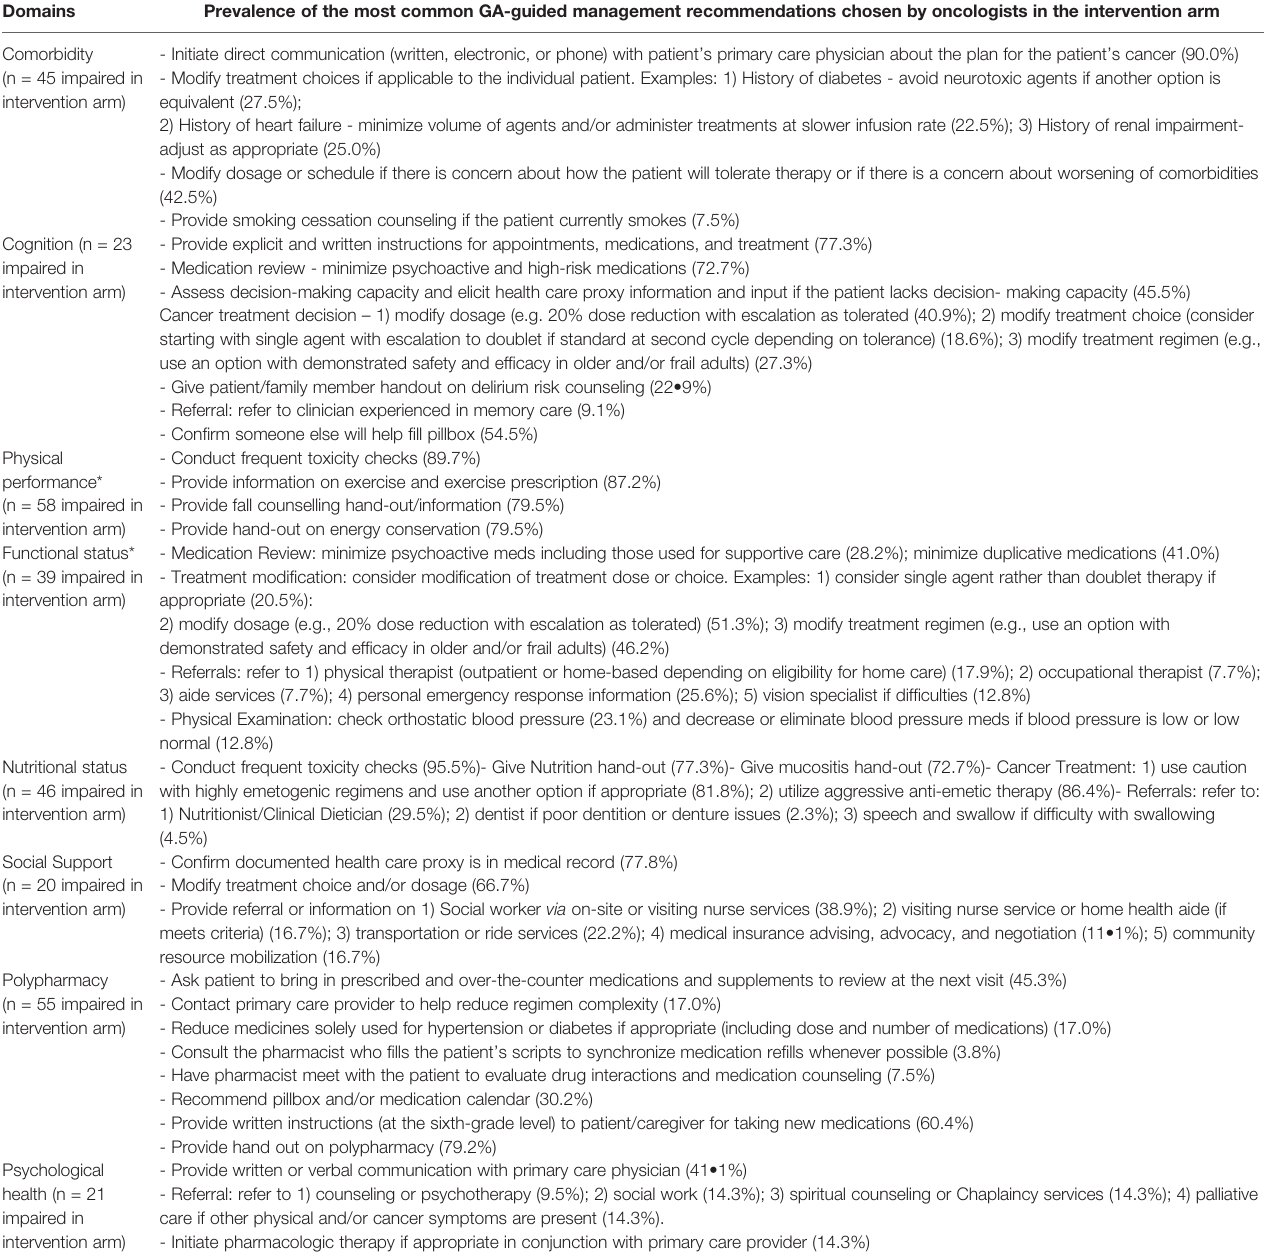
TABLE 3 | Geriatric assessment (GA) recommendations by domain.